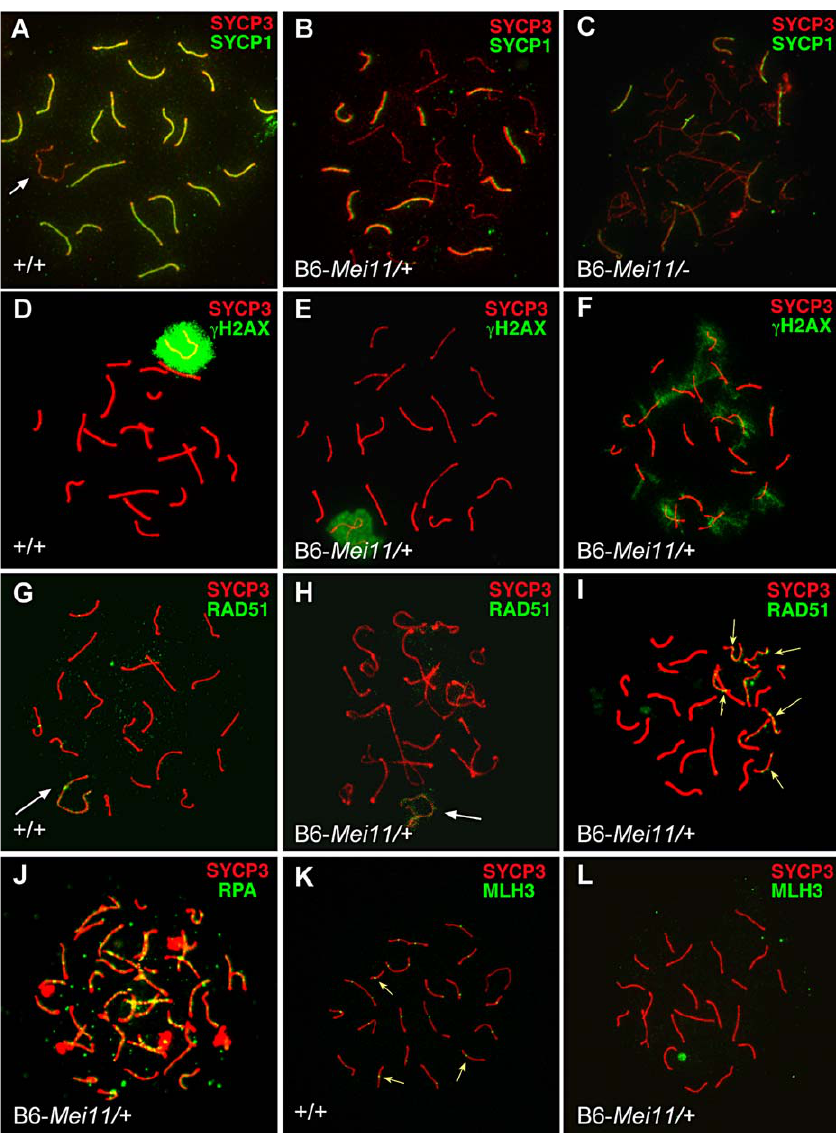
Figure 2. Synaptic Defects, Persistent DSBs, and Lack of Late Recombination Nodules in Mutant Spermatocyte Nuclei Panels show merged images of microspread juvenile (22 to 24 d postpartum) spermatocyte nuclei fluorescently immunolabeled with antibodies as indicated. Dmc1 Mei11 is abbreviated as Mei11; þ or (cid:3) in genotypes refers to the wt or null alleles of Dmc1, respectively. (A) Wt nucleus showing complete synapsis, as judged by overlap of SYCP1/3 staining, resulting in yellow. The white arrow in points to the XY pair. (B and C) Mixture of synapsed and asynapsed chromosomes in aberrant pachytene-like Mei11 / þ and Mei11 / Dmc1 (cid:3) spermatocyte nuclei. (D and E) In wt and pachytene stage B6- Mei11 / þ nuclei with fully synapsed autosomes, c H2AX decorates the XY body exclusively. (F) c H2AX stains asynapsed chromosomes in a pachytene-like, XY bodyndash;less mutant nucleus. (G and H) RAD51/DMC1 foci are present exclusively on the XY bodies (white arrows) of mid-pachytene nuclei. (I) Persistent RAD51/DMC1 foci are present on cores of presumably unsynapsed chromosomes in an aberrant pachytene-like Mei11 / þ nucleus (yellow arrows). (J) Abnormal persistence of RPA (yellow) on cores of mutant spermatocytes. (K) MLH3-positive foci, one to two per chromosome, are normally present on cores of mid- to late pachytene wt nuclei (see arrows for examples). (L) MLH3 foci (hence, chiasmata) are absent on meiotic cores of mid-pachytene–like and aberrant pachytene-like (not shown) Mei11 / þ nuclei. doi:10.1371/journal.pbio.0050105.g002 regions [17,18]. SYCP1 and SYCP3 decorate the axes of all 19 synapsed pachytene stage autosomes in wild-type (wt) spermatocytes, except for the XY bivalent, in which only the pseudoautosomal region (PAR) contains SYCP1 (Figure 2A). While chromosomes in the most advanced Dmc1 (cid:3) / (cid:3) nuclei were in a zygonema-like state and devoid of homologous synapsis (unpublished data; [11]), Dmc1 Mei11 / þ spermatocytes PLoS Biology |